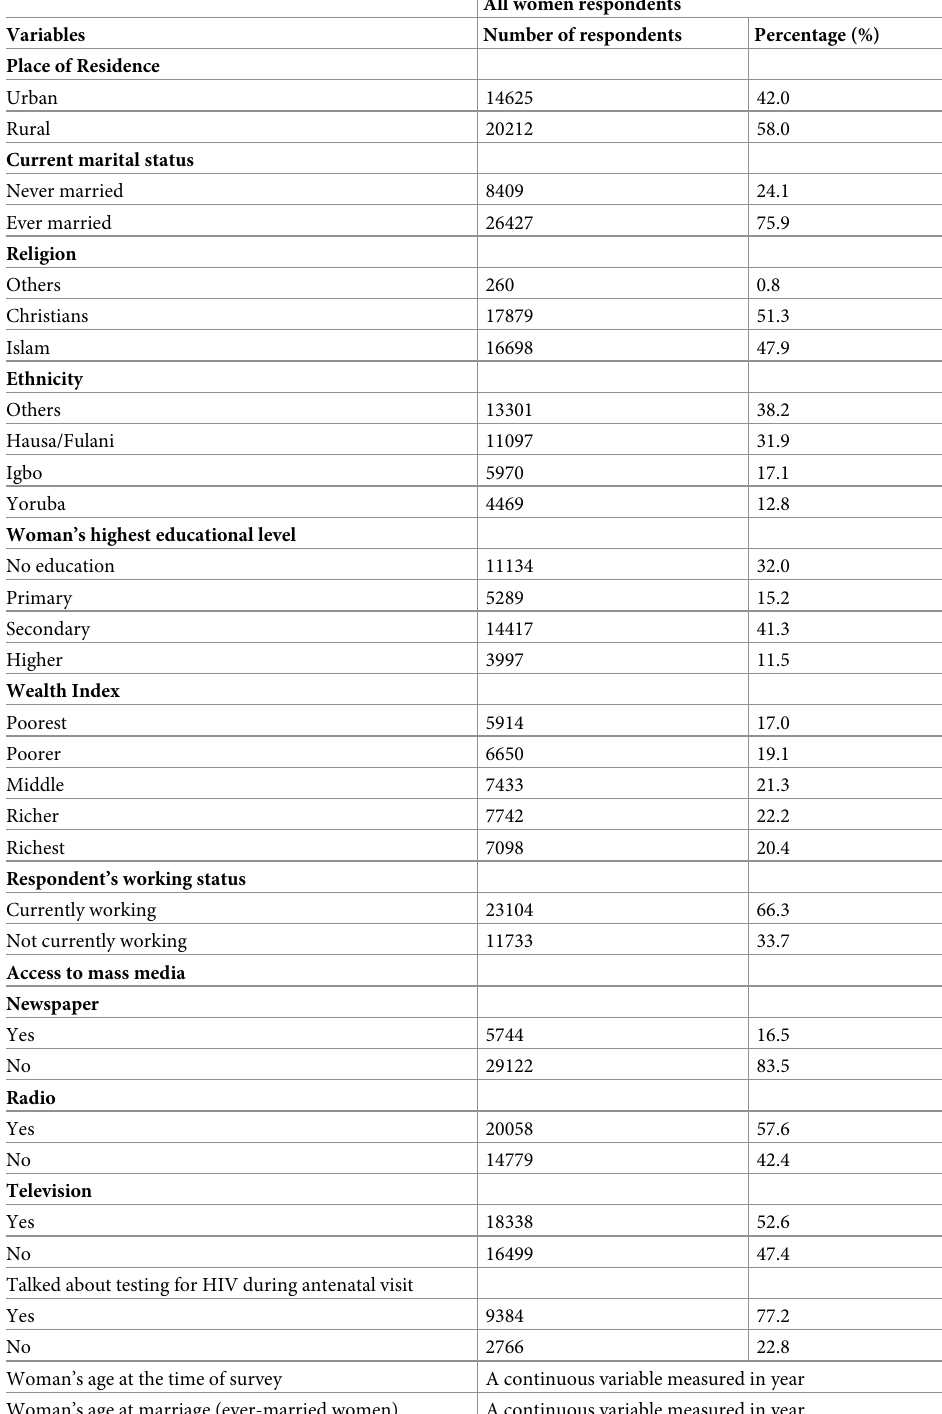
Table 1. Summary of individual covariates